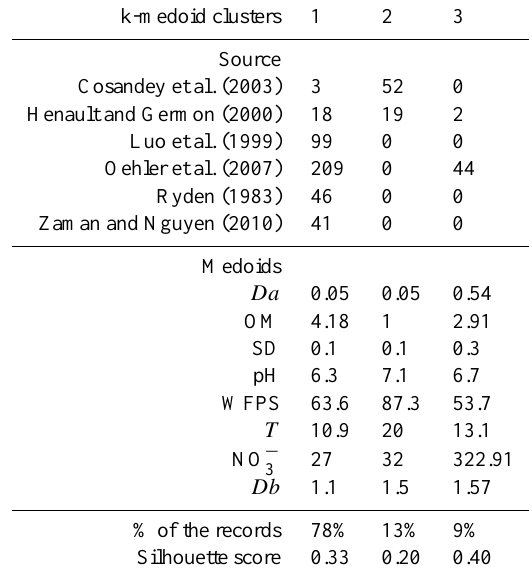
Table 3. Contingency table of the counts of records per data source and cluster (k-medoid cluster), and the mean silhouette width per cluster (can be between [− 1 , 1 ] , a score close to 1 meaning good clustering) k-medoid